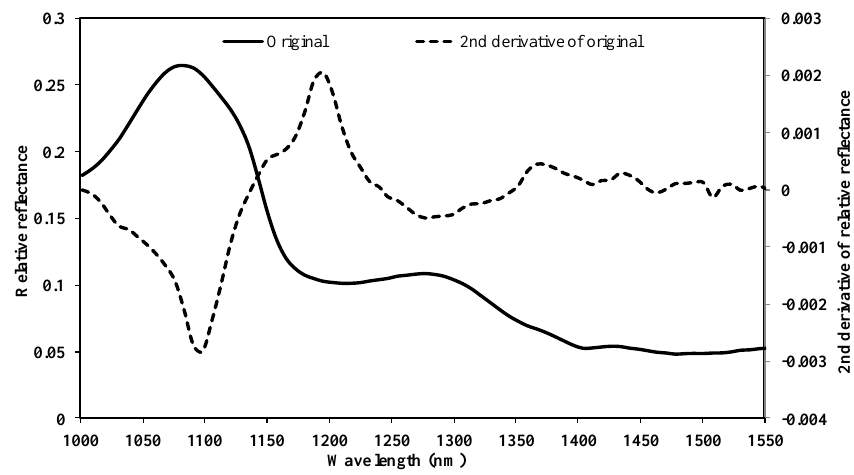
Figure 4. Typical reflectance spectra of intact tomatoes. Table 1. Characteristics of calibration and prediction sample